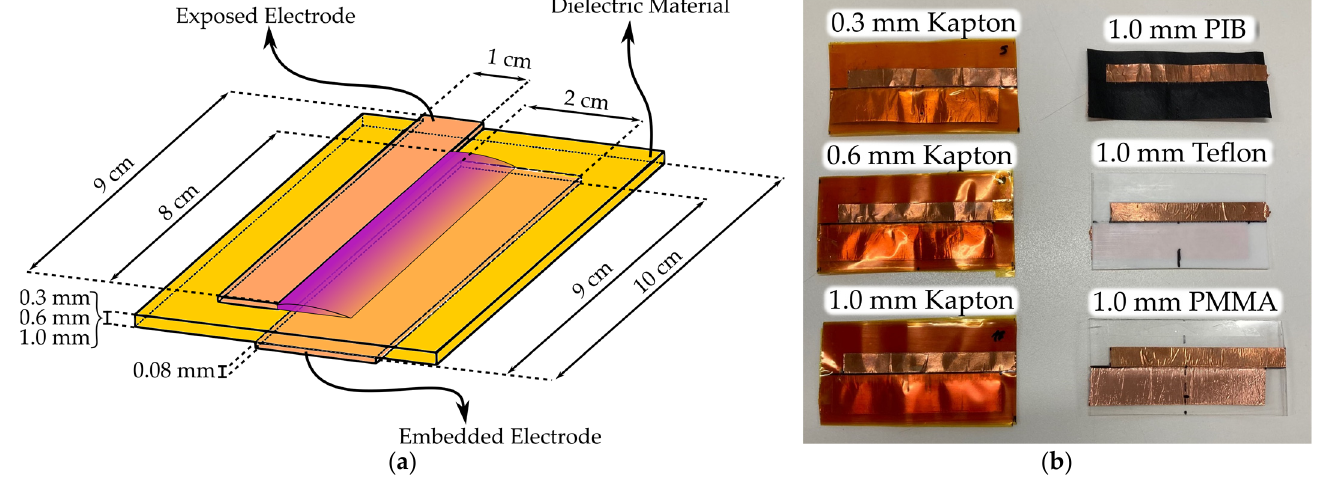
Figure 2. Plasma actuators tested ( a ) schematic of the plasma actuator’s dimensions; ( b ) photo of the fabricated plasma actuators.